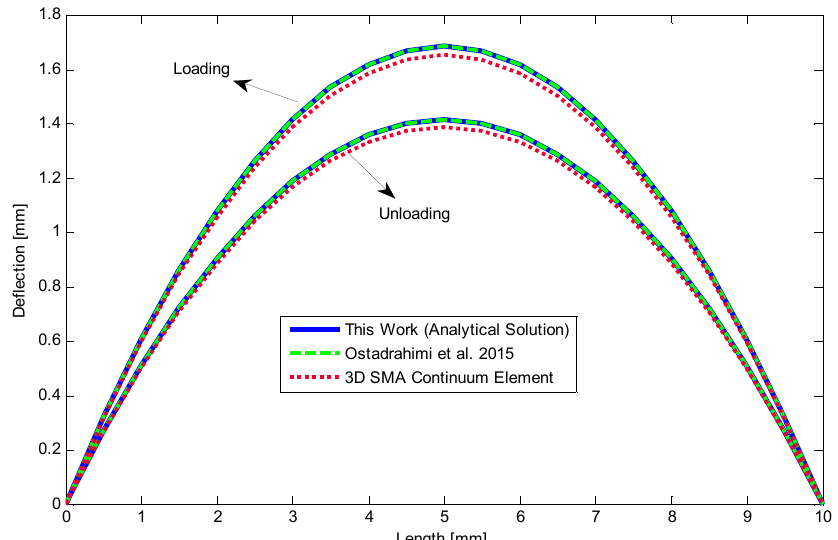
Figure 12. Deflection versus length of the SMA beam with symmetric material properties in loading and unloading [28].